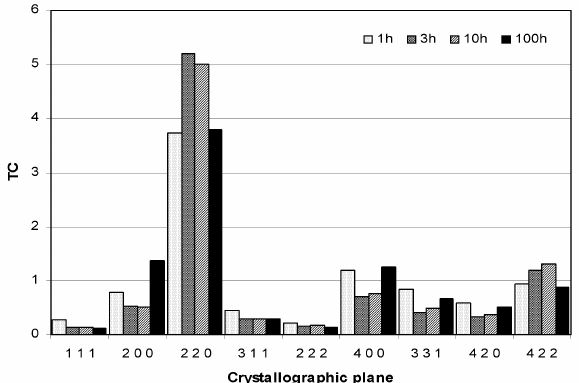
Figure 4. TC values of individual diffraction planes of Al-4 vol. % Al 4 C 3 material annealed for different times.